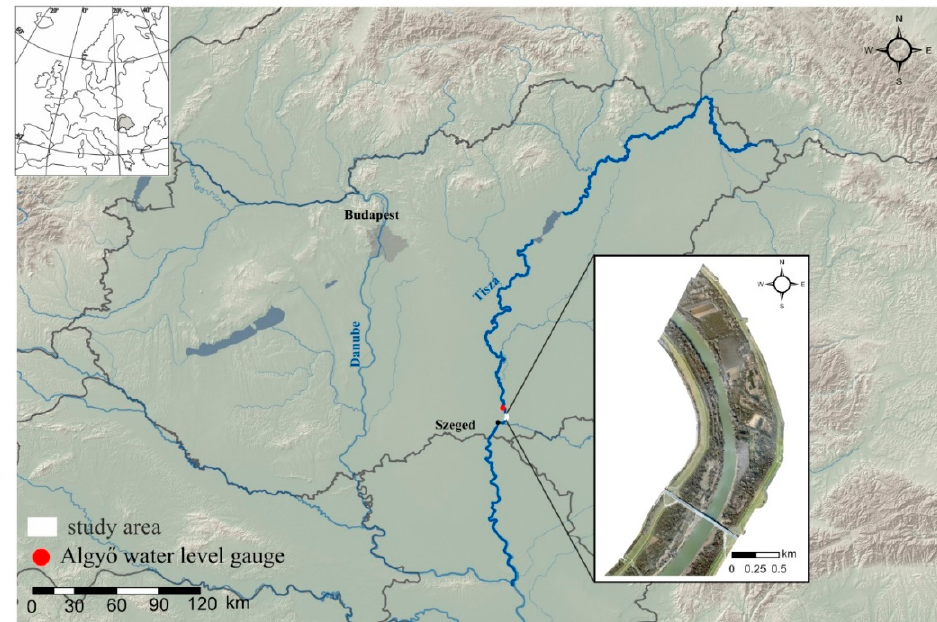
Figure 1. The studied floodplain area is located in the Lower Tisza, Hungary, Central Europe.